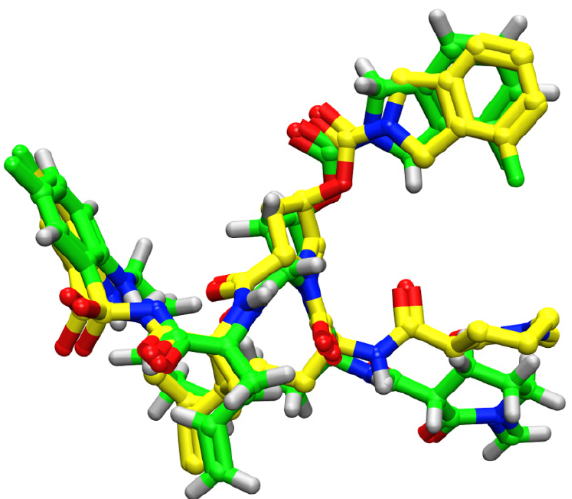
Figure 3. Superposition of co-crystallized and docked conformations of the reference ligand. Green native co-crystallized ligand and yellow docked ligand.